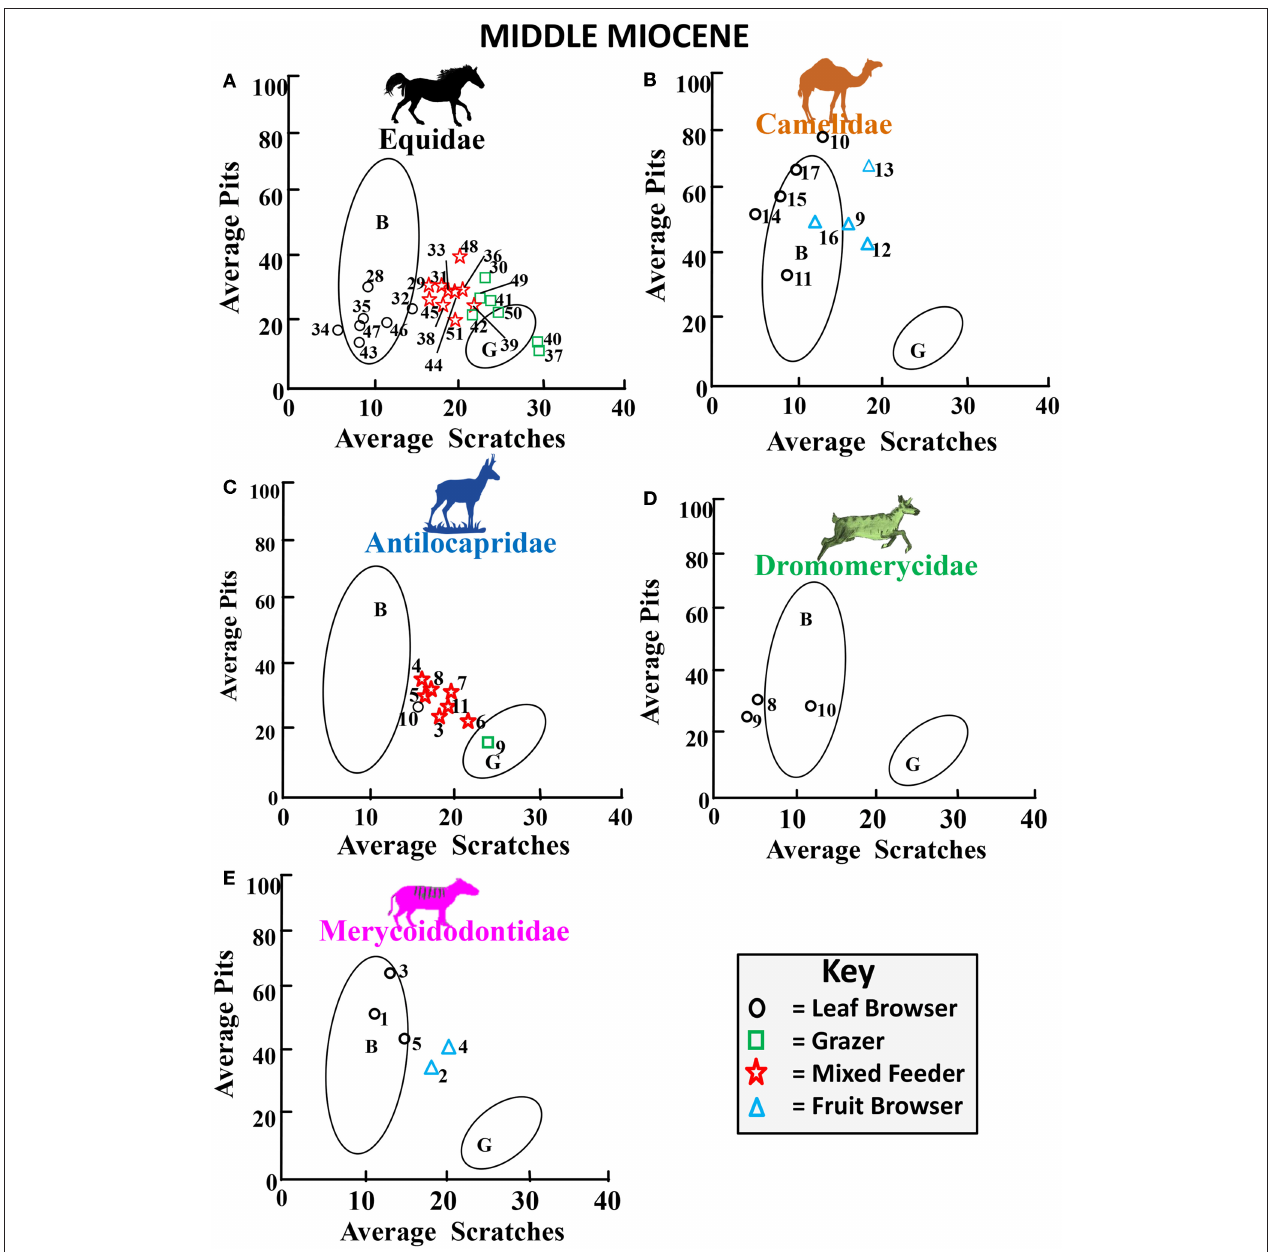
FIGURE 11 | Bivariate plot showing results for the average number of pits vs. the average number of scratches per taxon for Middle Miocene fossil equids (A) , camelids (B) , antilocaprids (C) , dromomerycids (D) , and merycoidodontids (E) plotted in reference to extant leaf dominated ungulate browsers (B), and extant grazers (G) at 35 times magnification (extant comparative data from Semprebon, 2002 and Solounias and Semprebon, 2002 ). Gaussian confidence ellipses (p = 0.95) on the centroid are indicated for the extant leaf browsers (B) and grazers (G) (convex hulls) adjusted by sample size. Key to Equidae: 28 = Parahippus avus , 29 = Parahippus integer , 30, 31 = Parahippus sp., 32, 33 = Hypohippus sp., 34, 35, 43 = Megahippus sp., 36 = “ Merychippus ” goorisi , 37 = Merychippus insignis , 38 = Scaphohippus intermontanus , 39 = Acritohippus isonesus , 40 = Acritohippus tertius , 41 = Calippus proplacidus , 42 = Protohippus perditus , 44, 45 = “ Merychippus ” calamarius , 46 = Cormohipparion quinni , 47 = Megahippus matthewi , 48 = Pseudhipparion retrusum , 49 = Protohippus supremus , 50 = Cormohipparion occidentale , 51 = Calippus martini . Key to Camelidae: 9, 15, 16 = Aepycamelus sp., 10 = Paramiolabis singularis , 11 = Aepycamelus proceras , 12, 13 = Procamelus sp., 14 = Miolabis princetonianus , 17 = Protolabis sp. Key to Antilocapridae: 3, 4 = Merriamoceros coronatus , 5 = Paracosoryx alticornis , 6 = Merycodus sabulonis , 7 = Meryceros joraki , 8 = Ramoceros sp., 9 = Paracosoryx alticornis , 10, 11 = Cosoryx furcatus . Key to Dromomerycidae: 8 = Dromomeryx whitfordi , 9, 10 = Drepanomeryx ( Matthomeryx ) sp. Key to Merycoidodontidae: 1 = Merychyus relictus , 2 = Brachycrus laticeps buwaldi , 3 = Ticholeptus zygomaticus , 4 = Brachycrus laticeps siouense , 5 = Merychyus medius medius .